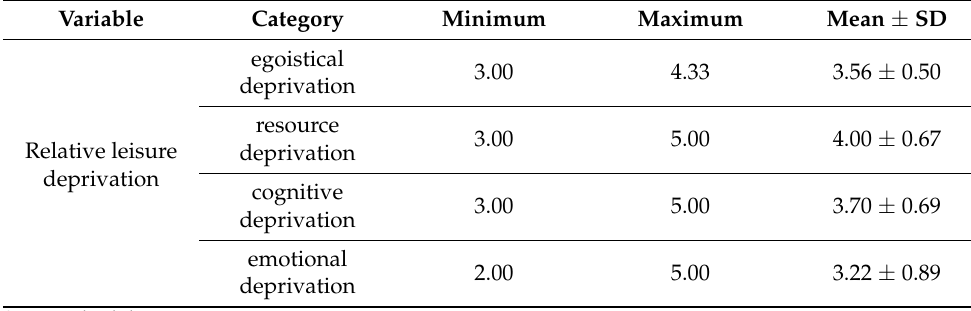
Table 2. Descriptive statistical analysis of relative leisure deprivation.